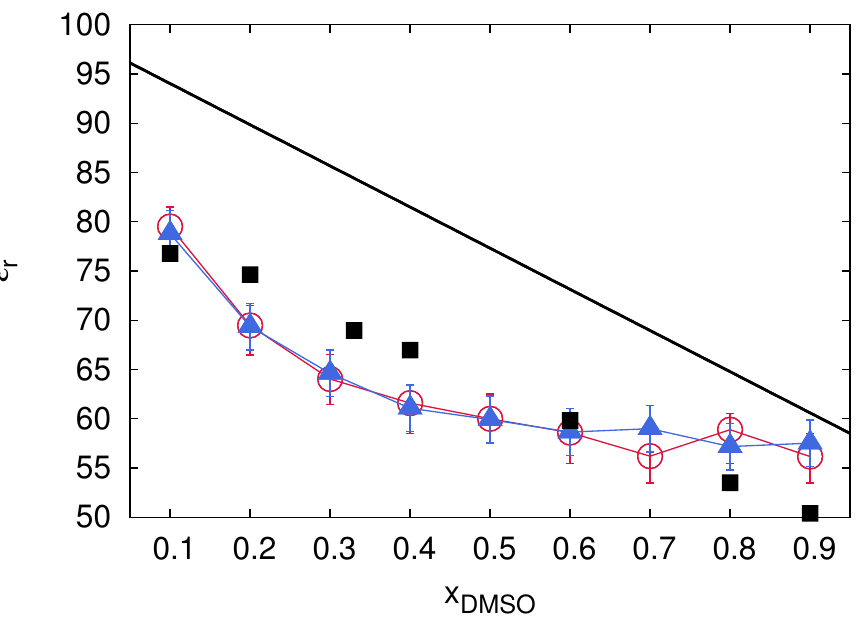
Figure 7. MD simulation outcomes of the resulting dielectric constant (cid:101) r for an aqueous DMSO solution with increasing mole fractions of DMSO x DMSO in presence (blue triangles) and absence of low concentrated ion pairs (bue). The corresponding values for TIP3P water and DMSO are (cid:101) TIP3P r = 95.32 and (cid:101) DMSO r = 55.54. The black squares correspond to experimental results. Figure reproduced from Ref.